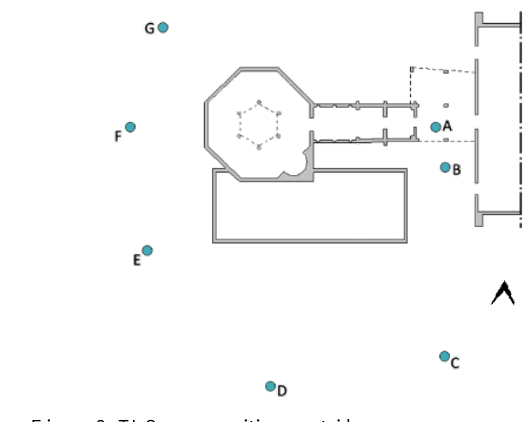
Figure 3. TLS scan positions outside